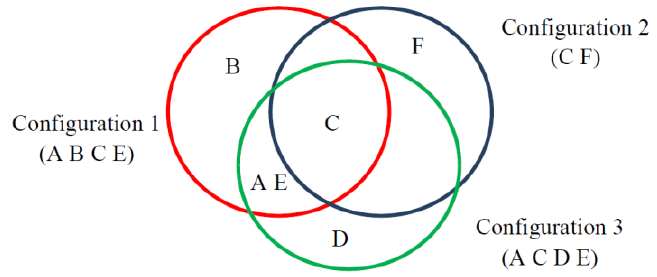
Figure 4. Determination of minimal set modules; where A— x axis slide, B— y axis slide, C— z axis slide, D— x axis rotation table, E— z axis spindle, F— y axis spindle.